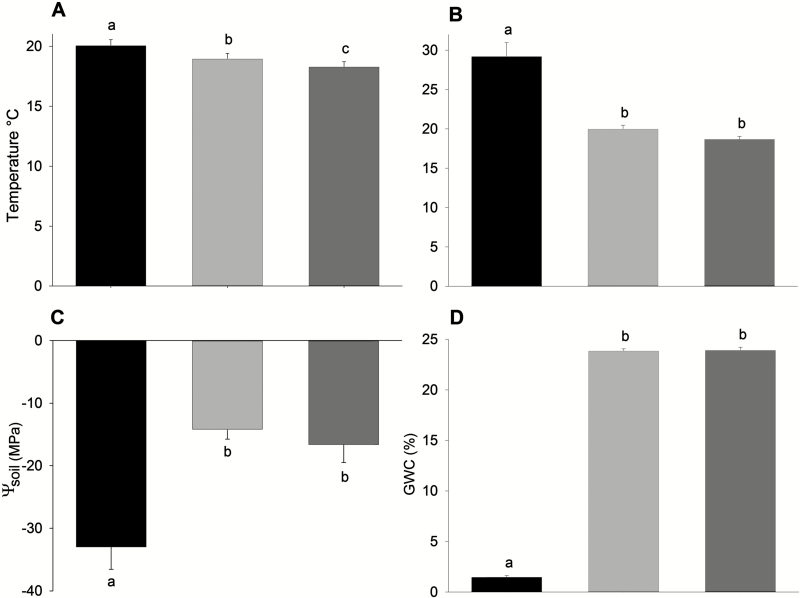
Abiotic conditions in each microhabitat: open interspaces (black), under conspecific shrubs (dark grey) and rock cavities (light grey). (A) Air temperature. (B) Soil temperature. (C) Soil water potential. (D) Gravimetric soil water content. Lowercase letters indicate differences among groups. Means(March and September) ± 1 SE.